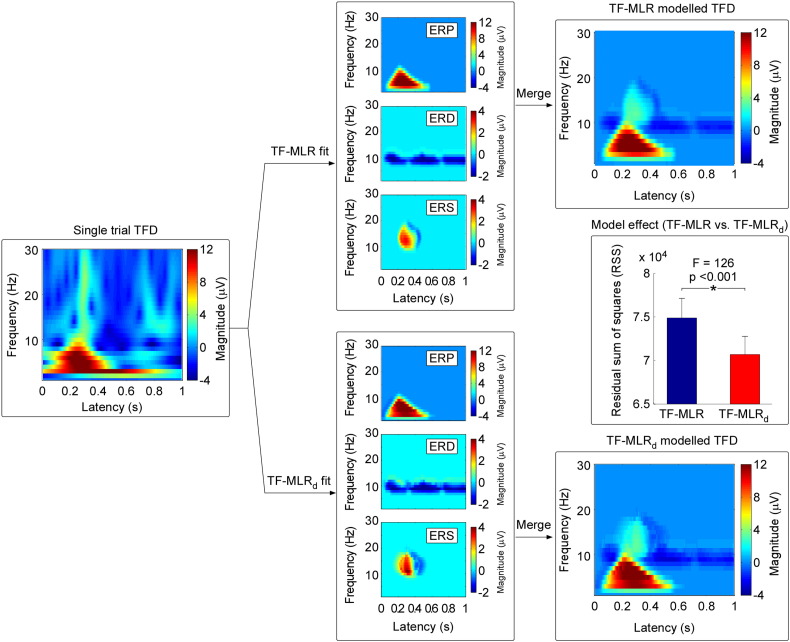
Example of a single-trial TFD modelled using both TF-MLR and TF-MLRd.Left panel: A single-trial TFD of a laser-elicited EEG response recorded at electrode Cz. Middle panel: Time-frequency response features (ERP, ERD and ERS) fitted using TF-MLR and TF-MLRd. Note that the information-of-interest (i.e., the ERP, ERD and ERS responses) is preserved, while the information-of-no-interest (e.g., background EEG noise) is largely removed, thus increasing the response SNR. Right panel: The sum of the fitted ERP, ERD and ERS responses constituted the modelled single-trial TFD. TF-MLRd provides a significantly better fit of single trials than TF-MLR (F = 126, p < 0.001).